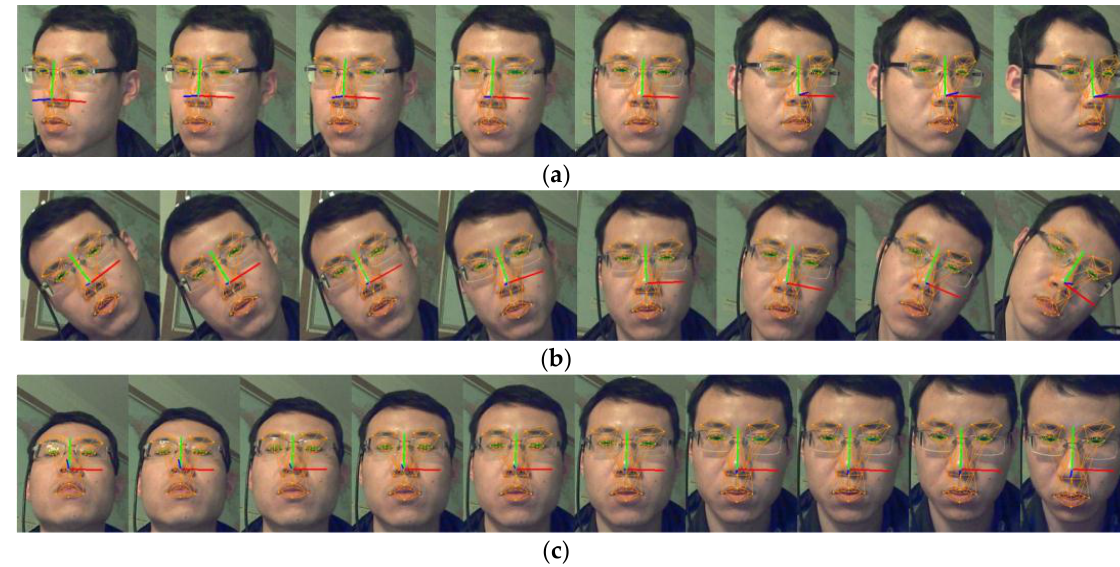
Figure 3. Images of rotation tracking results. ( a ) Is the images of yaw tracking; ( b ) is the images of roll tracking and ( c ) is the images of pitch tracking.